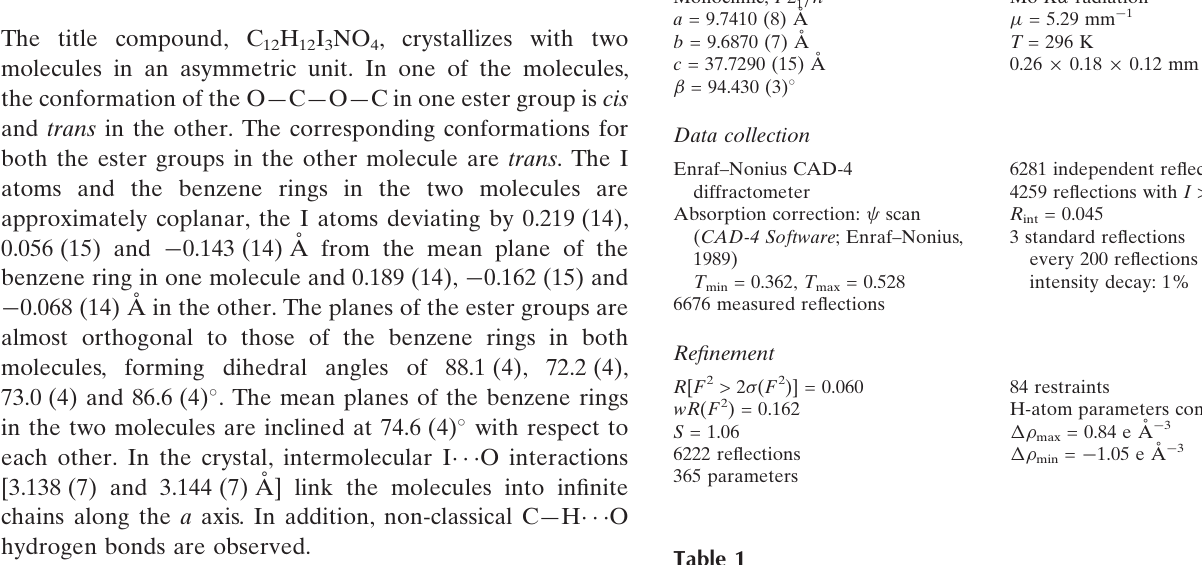
Hydrogen-bond geometry (A˚ , (cid:3)